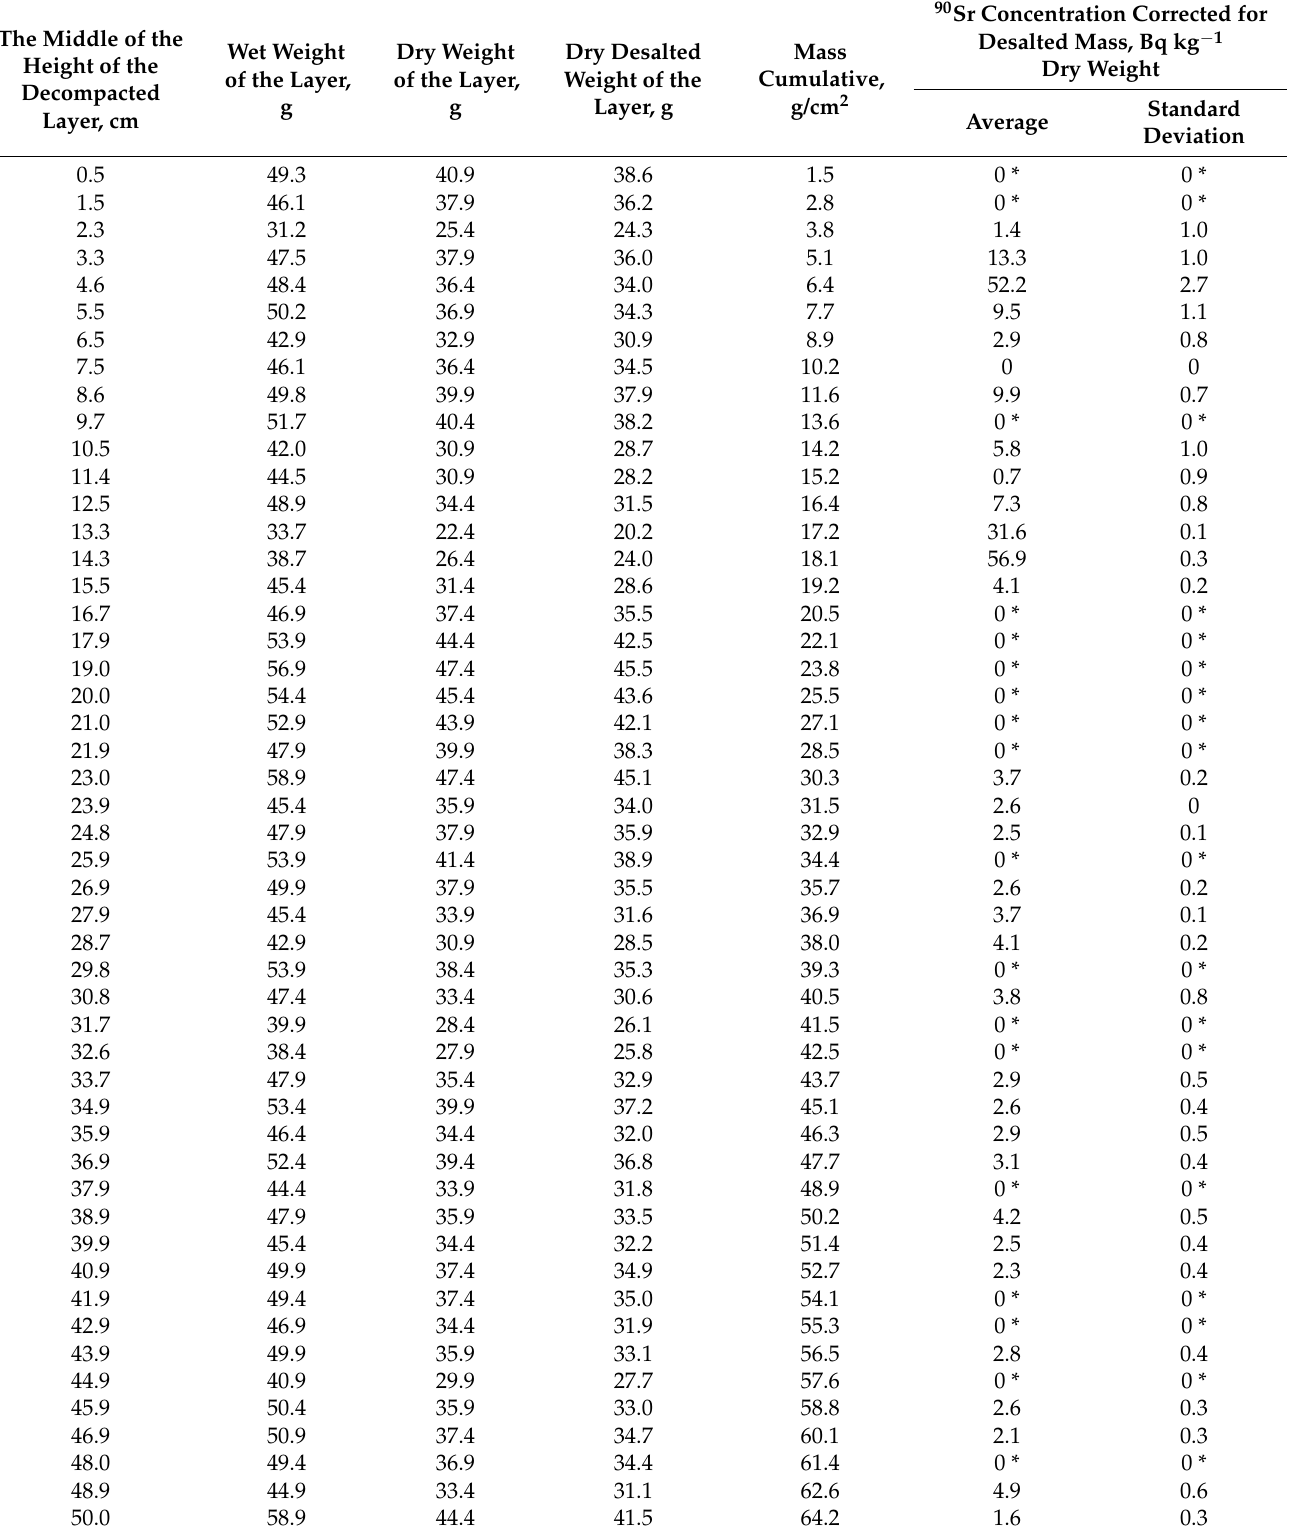
Table 1. The concentration of 90 Sr in the core of bottom sediments was taken in Lake Aktashskoye on 17 August 2017, at a water salinity of 200 g L − 1